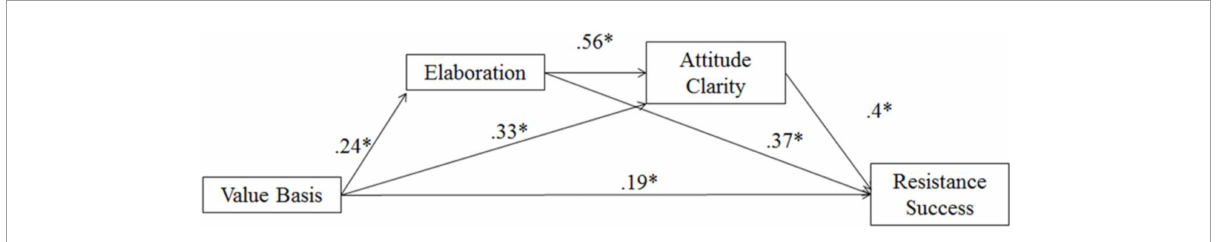
FIGURE4 Multiple mediation of value basis on resistance success with perceived elaboration and attitude clarity as mediators in Study 3; ∗ p < 0.05.